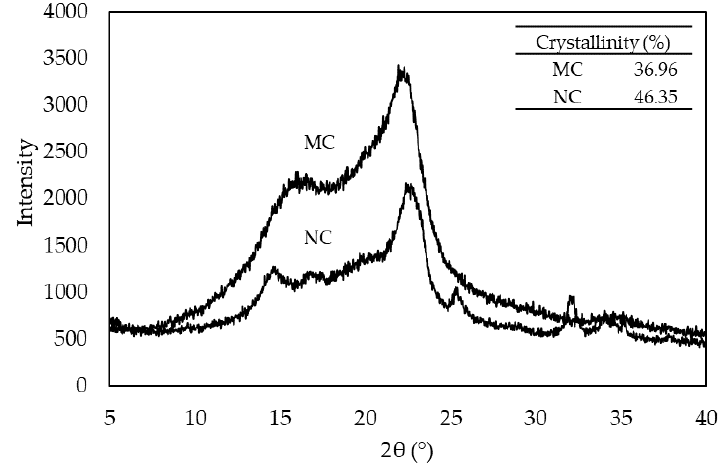
Figure 2. XRD patterns of microcellulose (MC) and nanocellulose (NC) powders. 217